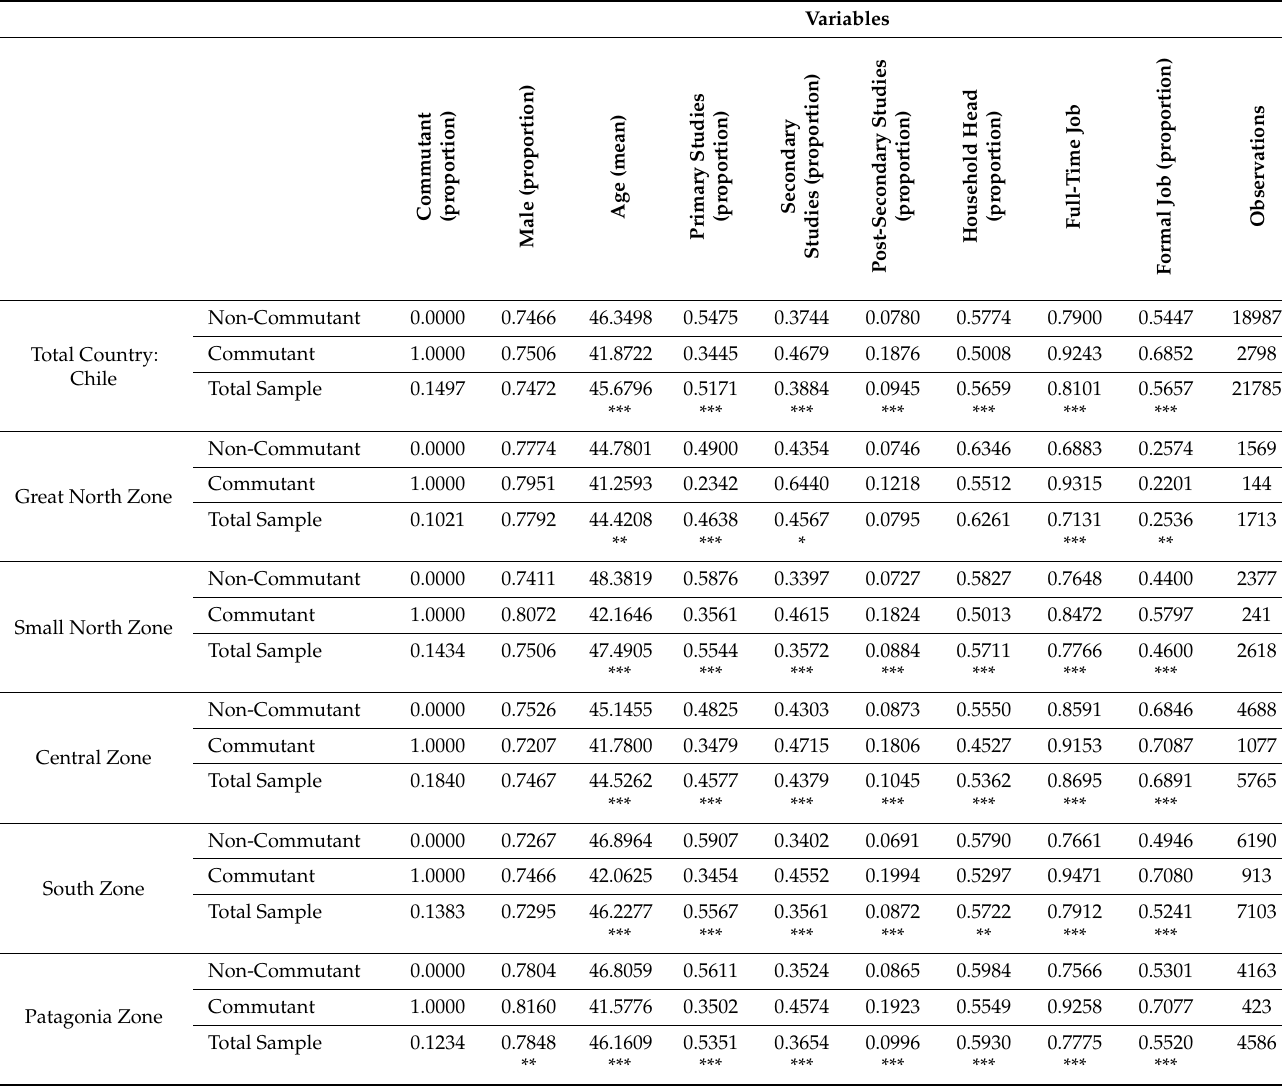
Table 2. Description of the data sample. Agricultural worker sectors in Chile, by